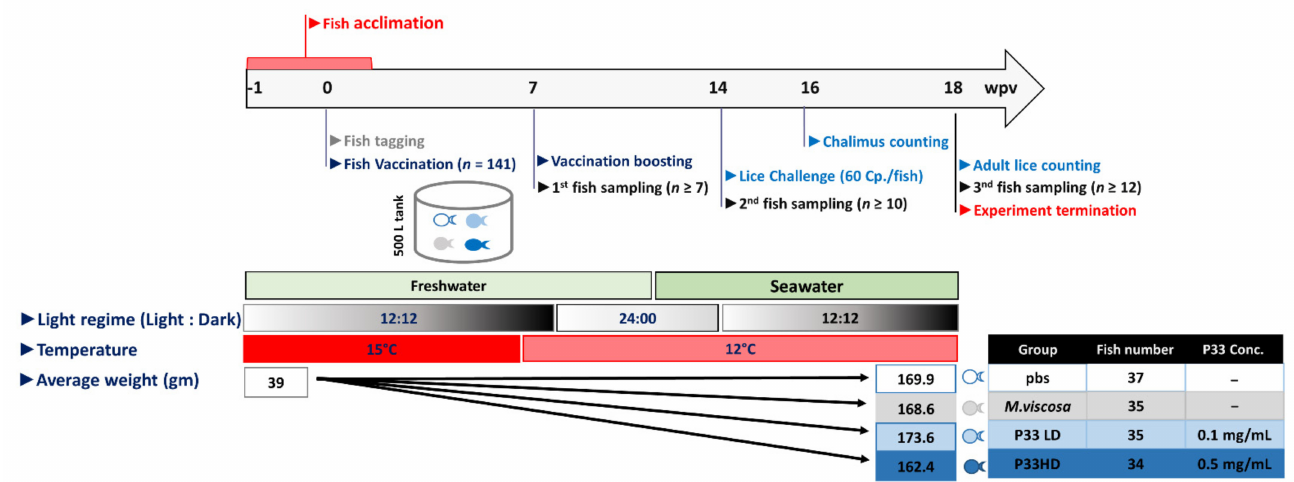
Figure 1. A schematic diagram showing the experimental design and the timeline of the P33 vacci- nation trial. Salmon fish were acclimatized for one week before they were tagged and vaccinated with P33 vaccine (low and high doses; LD and HD, respectively) or injected with pbs and M. viscosa vaccine (as a negative controls) at 1 wpa (0 wpv). At 8 wpa (7 wpv), the fish in the LD and HD were given a booster dose of P33 vaccine, and fish in the negative control groups were injected with the same material used in the first injection. All fish were challenged with lice copepodid at 14 wpv, and the chalimus and adult stages of sea lice were counted at 16- and 18-wpv, respectively. wpa: weeks post-acclimatization, wpv: weeks post-vaccination, Cp: copepodid. Conc.: Concentration, PBS: phosphate-buffered saline, LD: low dose, HD: high